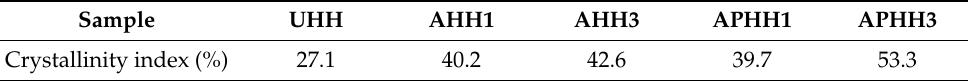
Figure 3. XRD patterns of untreated and treated hemp hurd powders. Table 2. The crystallinity index of untreated and treated hemp hurd powders.